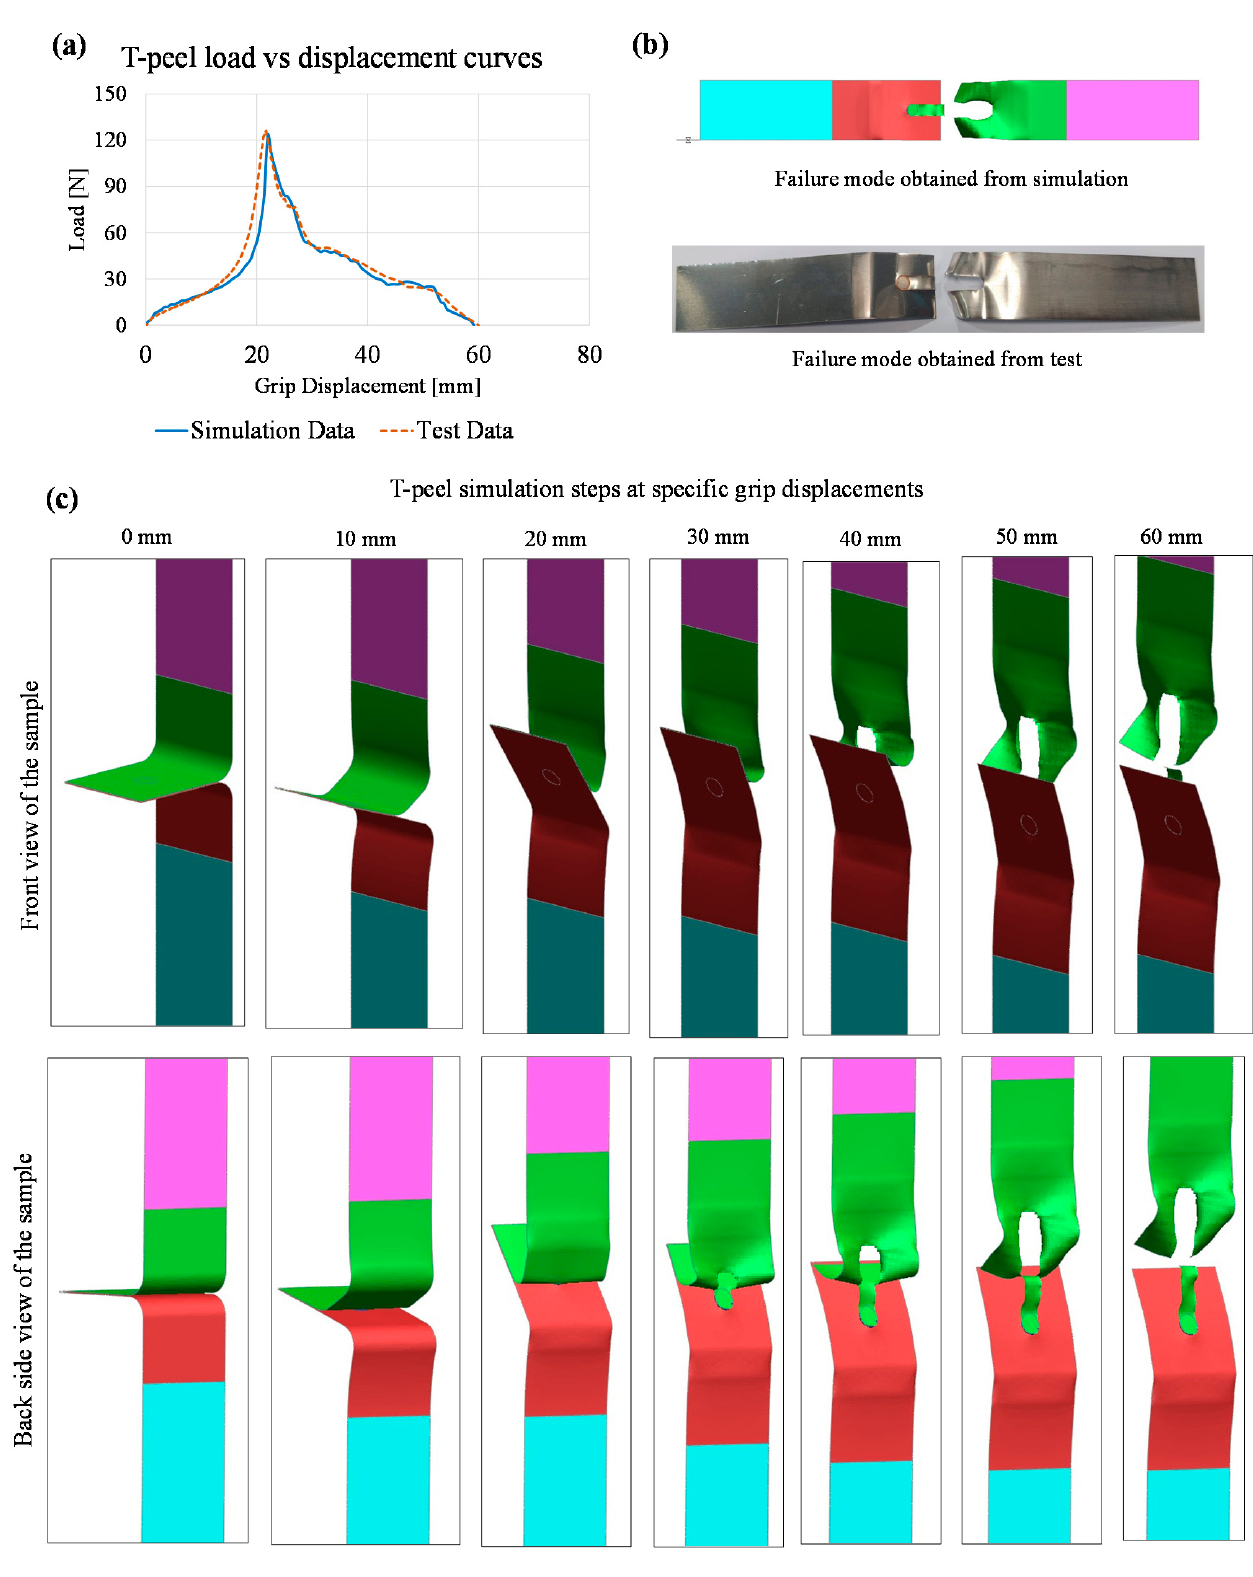
Figure 8. Simulation of T-peel test considering 5 mm diameter circular seam: ( a ) comparison of load–displacement curves obtained from simulation and tensile test, ( b ) failure modes obtained from simulation and test, and ( c ) sequence of images from the simulation at specific grip displacement.